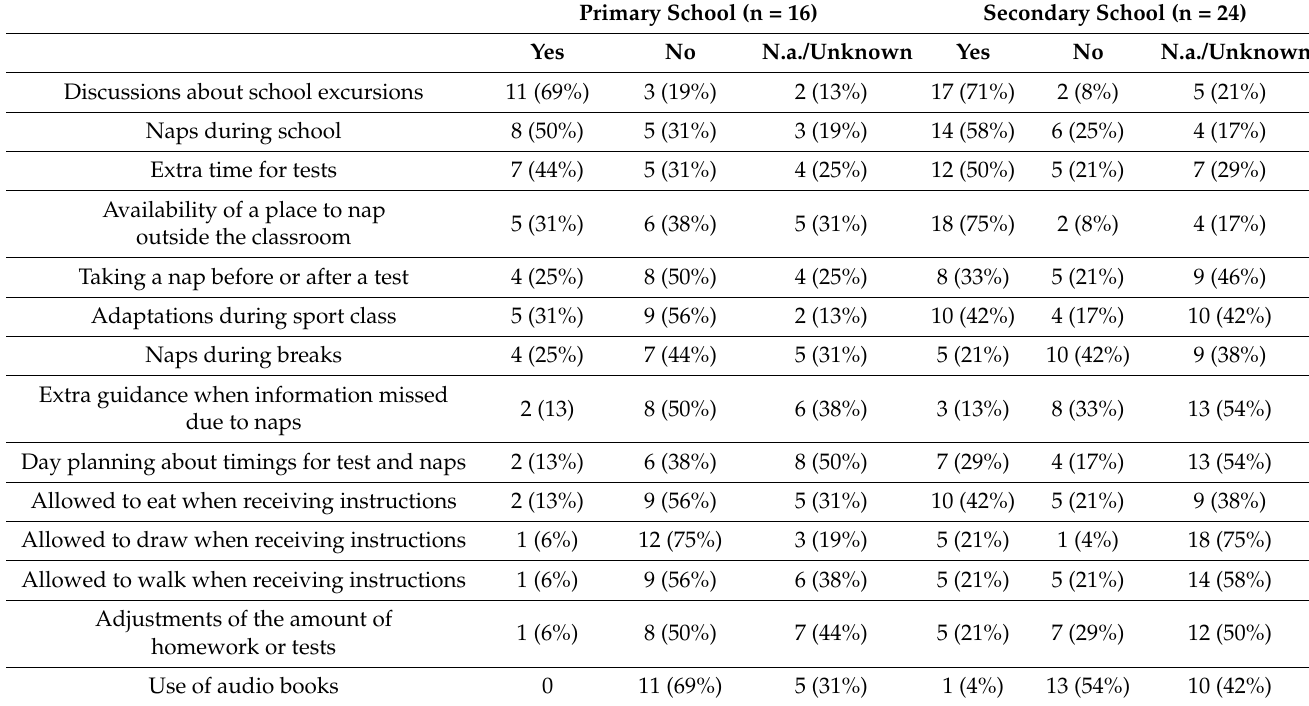
Table 4. Arrangements about adjustments made at primary and secondary school according to